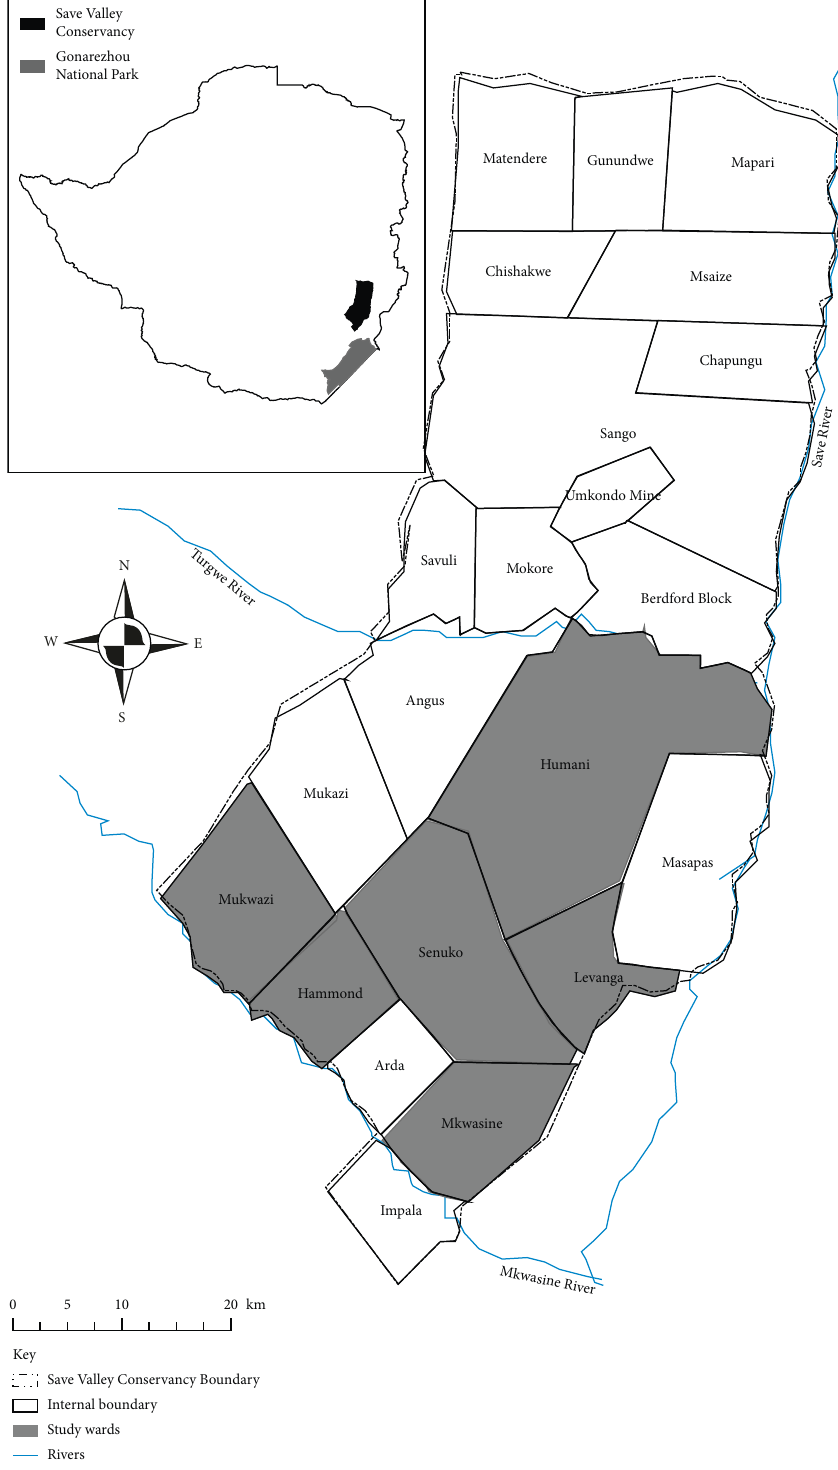
Figure 1: Map of the study